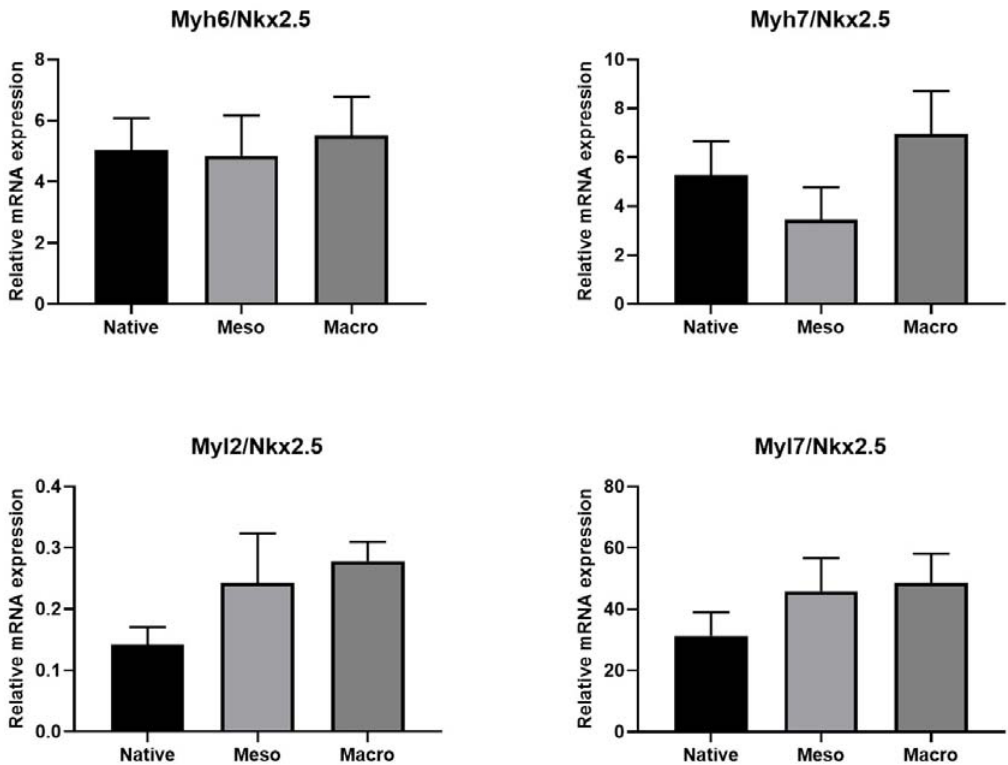
Figure 6. Ratio of gene expression (Myh6, Myh7, Myl2 and Myl7) to reference gene (Nkx2.5). Evidence of mature cardiomyocytes. Cardiomyocyte maturation was not significantly different on meso- and macro-structured substrates. Therefore, there is no need to provide a statistical analysis.